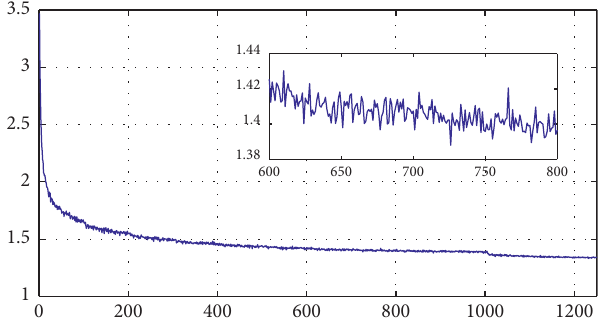
Figure 6: The curve of loss varying with epochs for ModelNet40, and it includes five training in one epoch.